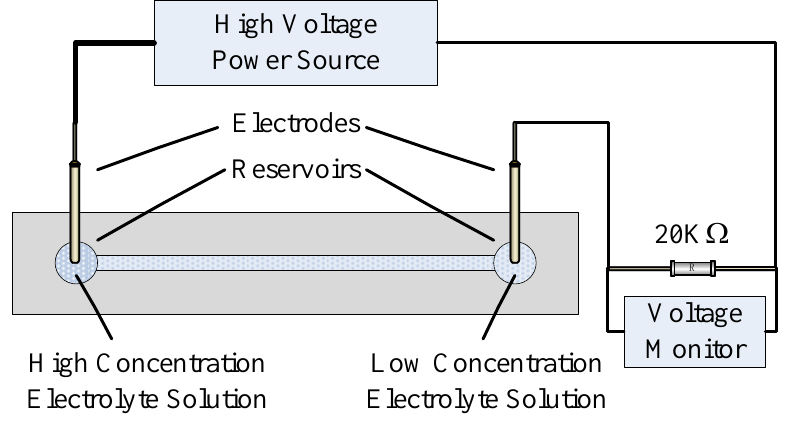
Figure 14. Measurement of the electro-osmotic flow rate using the current monitoring method.